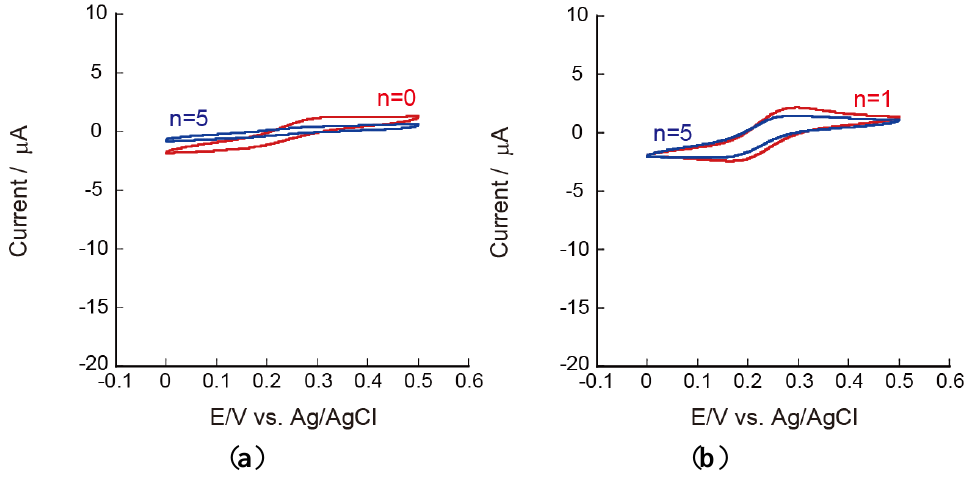
Figure 6. CVs of 5 mM Fe(CN) 63− ions on ( a ) PEI(PVS/CHI) films at pH